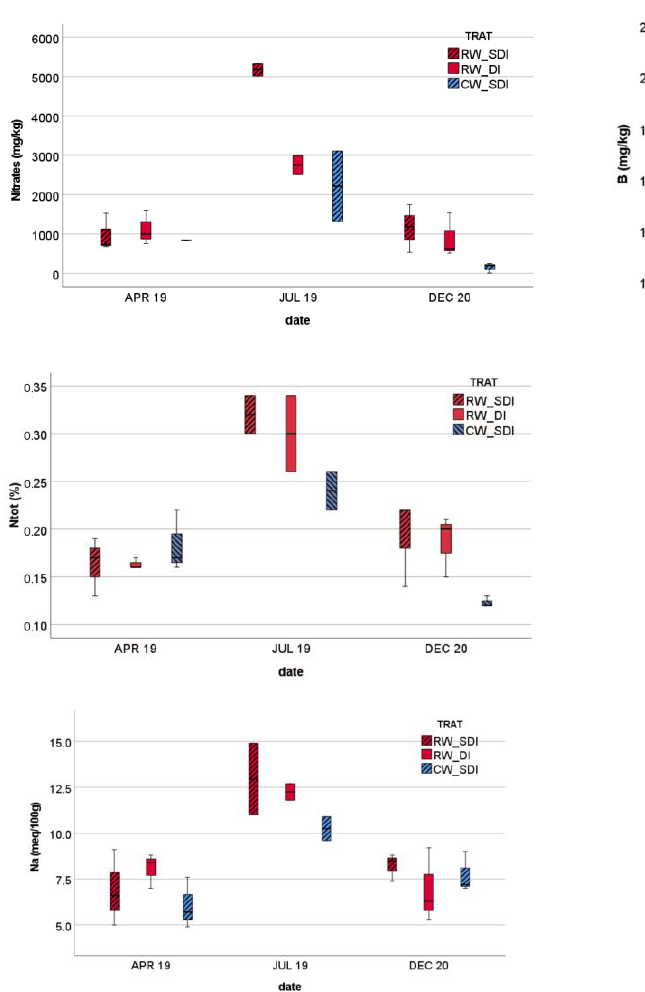
Figure 1. Soil EC and nitrates (mean of the whole experimental field) evolution over time, includ- ing the pre- and post-manure additions, and once irrigation treatments had been applied (( a ), EC; ( b ), nitrates).